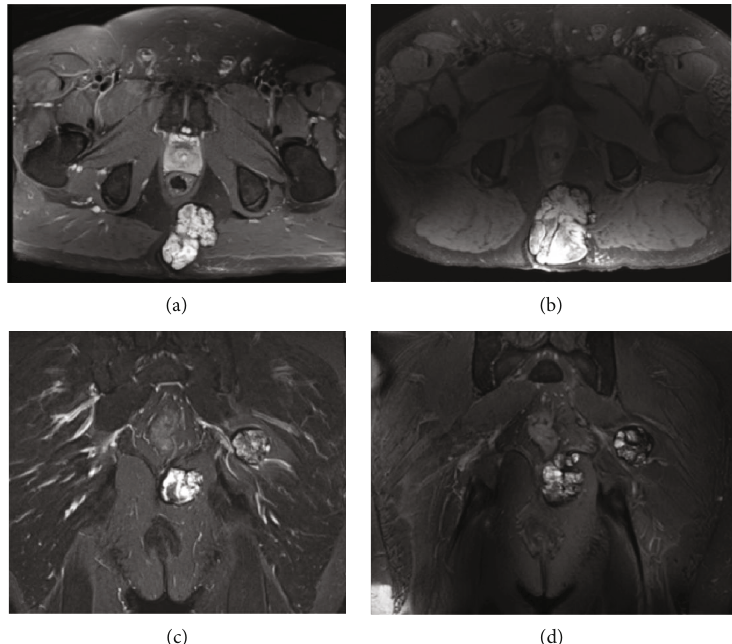
Figure 1: Initial (a, c) and 3-year follow-up (b, d) axial and coronal T2-weighted magnetic resonance imaging of the pelvis (Patient 1), demonstrating both the primary mass and the satellite